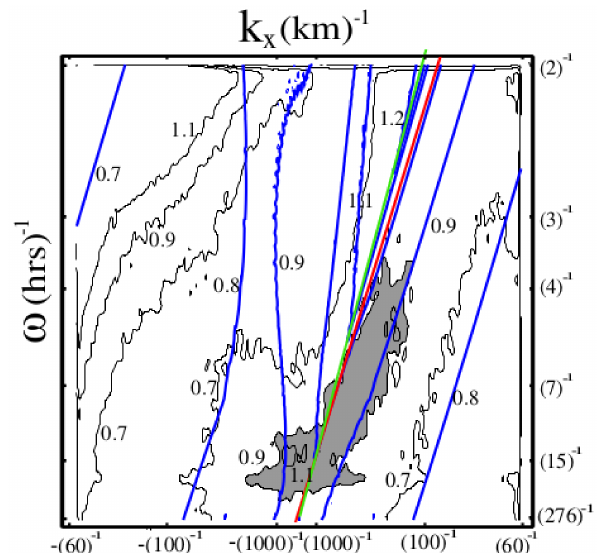
Fig. 3. Contour plot in the 2-D ( k x , ω ) space (i.e. integrated over k y ) . Black lines: the empirical spectral density divided by the “tur- bulent background” (i.e. the fit of Eq. (18) with imposed H wav = 0; region of maxima relevant to Kelvin waves indicated in grey). Blue − 2 H wav (cid:12) (cid:12) 0 (cid:14) v lines: |˜ g wav | 2 = with param- (cid:12) ω (cid:12) wav + k k k sign ( k · µ ) eters H wav = 0 . 08 ± 0 . 04 and v wav = 1 . 4 ± 0 . 8 integrated over k y (the maximal line is indicated in green). In red: the dispersion re- lation for Kelvin waves (corresponding to h = 12m in Fig. 3 of Wheeler and Kiladis,